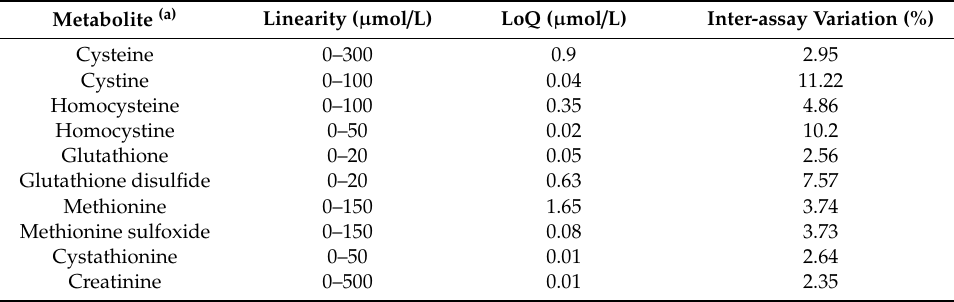
Table 2. Linearity, limit of quantification and inter-assay